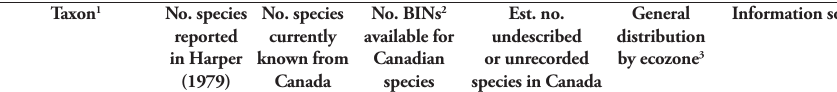
Table 1. Census of Plecoptera in